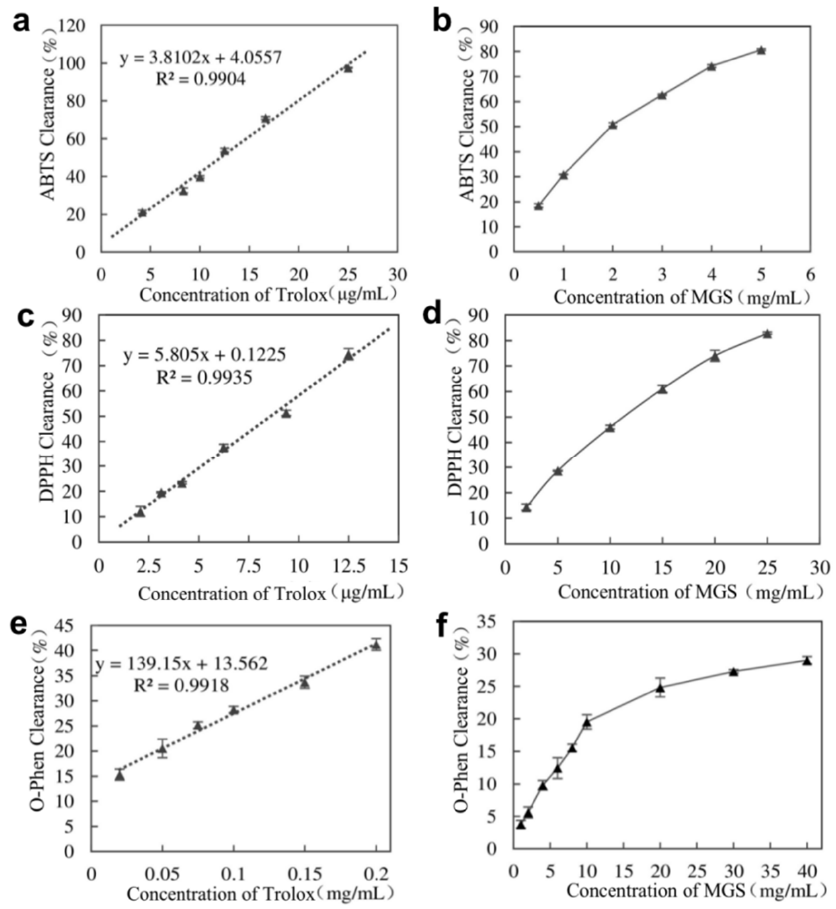
Figure 5. Evaluation of encapsulated MGS antioxidant capacity. ( a , b ) ABTS determination; ( c , d ) DPPH determination; and ( e , f ) O-Phen determination.